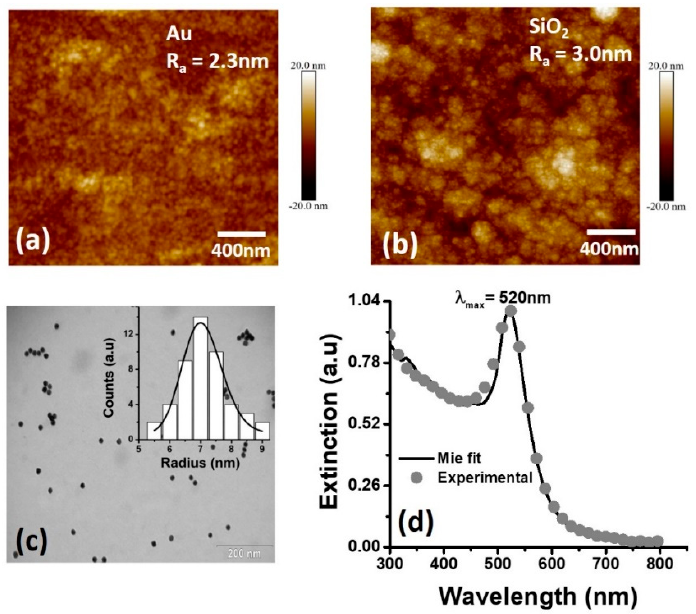
Figure 3. ( a ) AFM morphology image of the 49 nm gold thin film and ( b ) the 670 nm SiO 2 layer constituting the DLWGs used in the present work. ( c ) Typical TEM image of the citrate colloidal solution of AuNPs used in the optical sensing experiments. A log-normal distribution is used to obtain the best fit to the experimental statistical distribution, represented as continuous line in the inset. ( d ) Comparison between the experimental (grey circles) and theoretical (continuous black line) extinction spectra of the citrate colloidal dispersion of AuNPs. The fit on the experimental data was obtained applying the Mie theory with quadrupole orders [31].